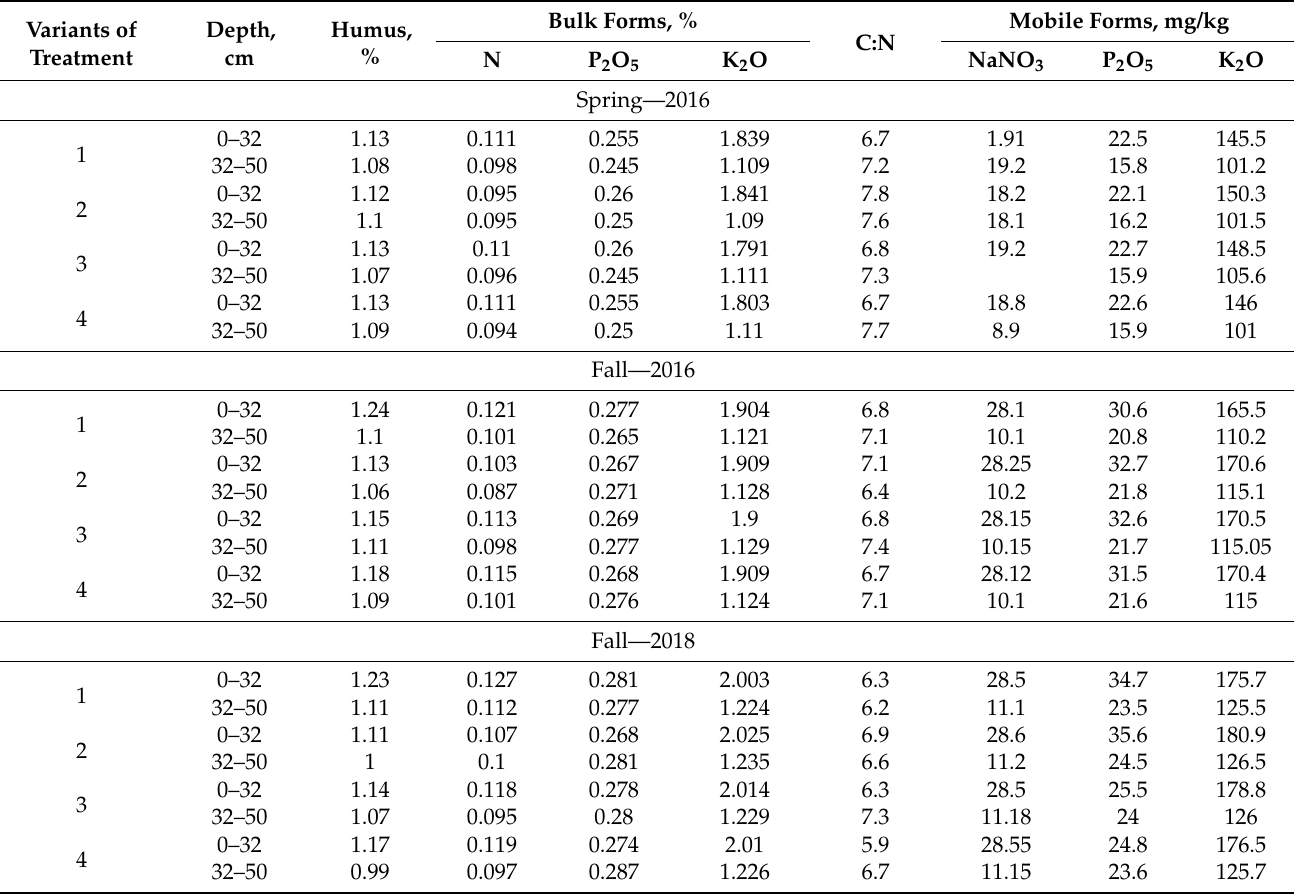
Table 3. Agrochemical characteristics of